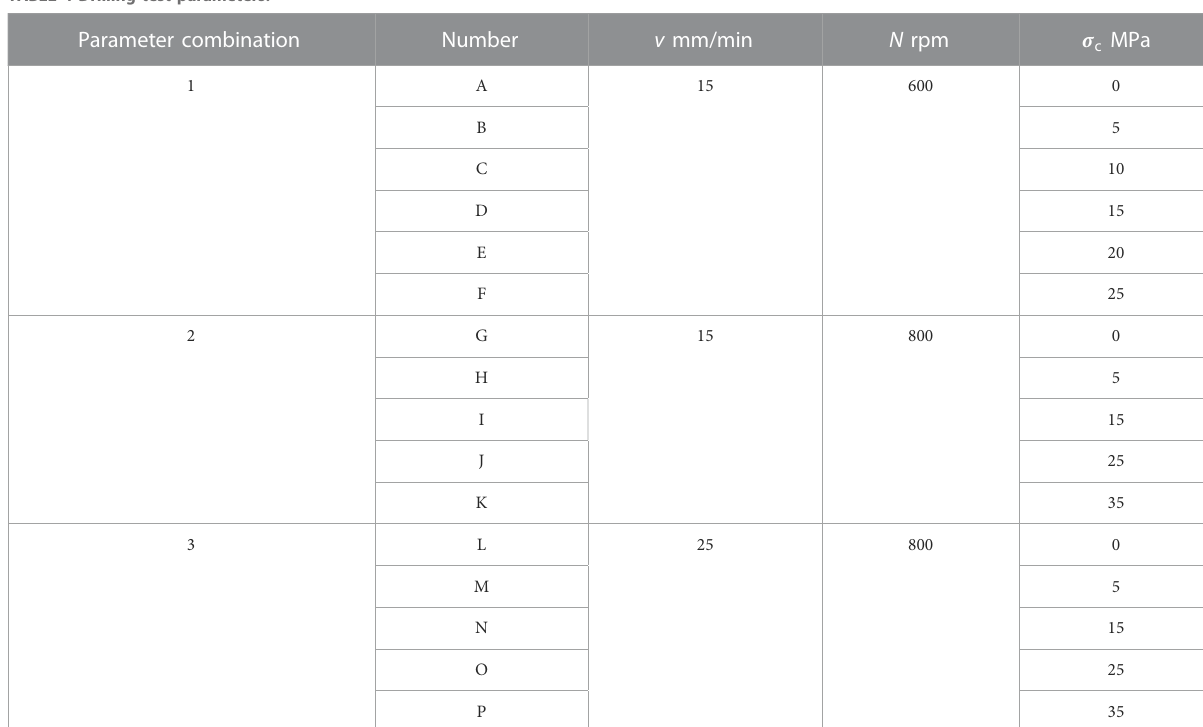
TABLE 4 Drilling test